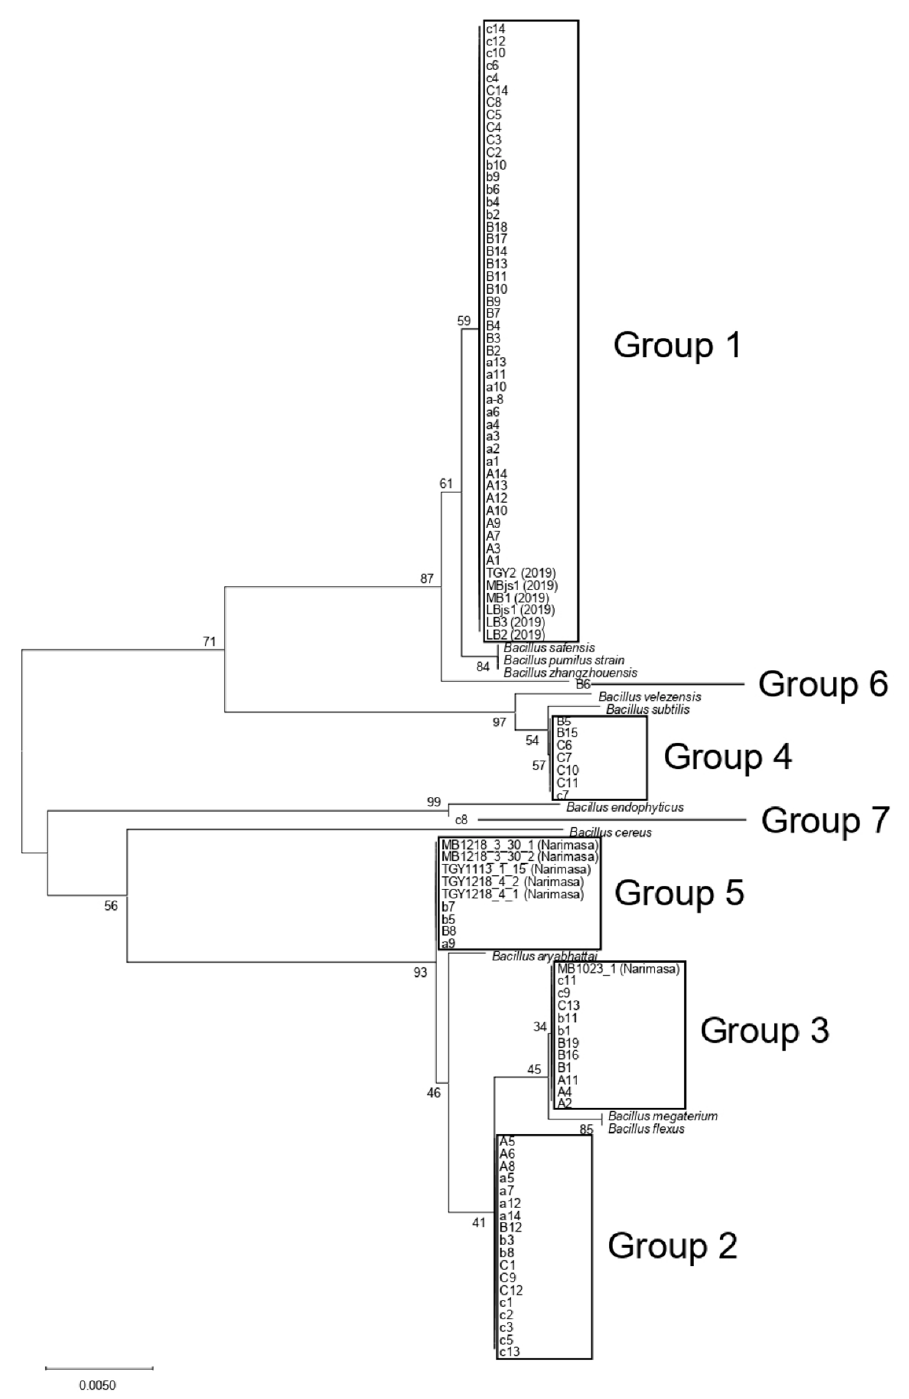
Figure 2. Phylogenetic relationships among 16S rRNA gene sequences of the 92 isolates from Shiraki Tsunesuke Sake Brewery, 6 isolates from Narimasa Sake Brewery, and 10 known species of Bacillus . A neighbor-joining tree was constructed with 1000 bootstrap replicates using MEGA X [18]. The evolutionary distances were computed using the maximum composite likelihood method [19], and are in the units of the number of base substitutions per site. All positions containing gaps and missing data were eliminated (complete deletion option). There were total 392 positions in the final